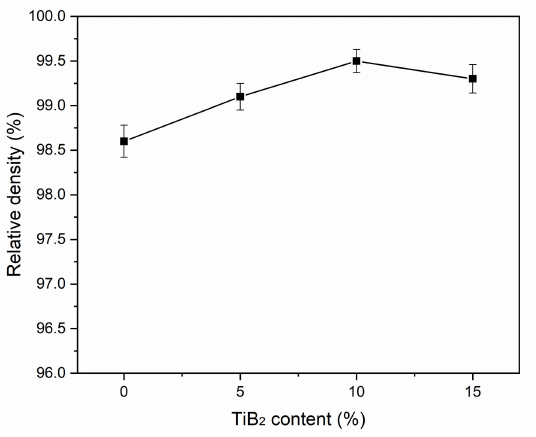
Figure 5. The relative density of Al 2 O 3 /TiC/TiB 2 ceramic tool materials with different TiB 2 contents. Further, elemental analysis of the Al 2 O 3 /TiC/10 vol.% TiB 2 ceramic tool